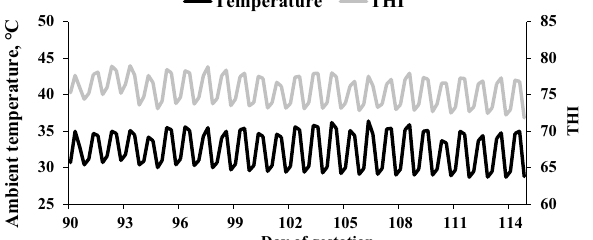
Figure 5. The ambient temperature and temperature humidity index (THI) during heat stress in sows during the experimental period. Ambient temperature (black line) and (THI) temperature-humidity index (grey line) during experimental